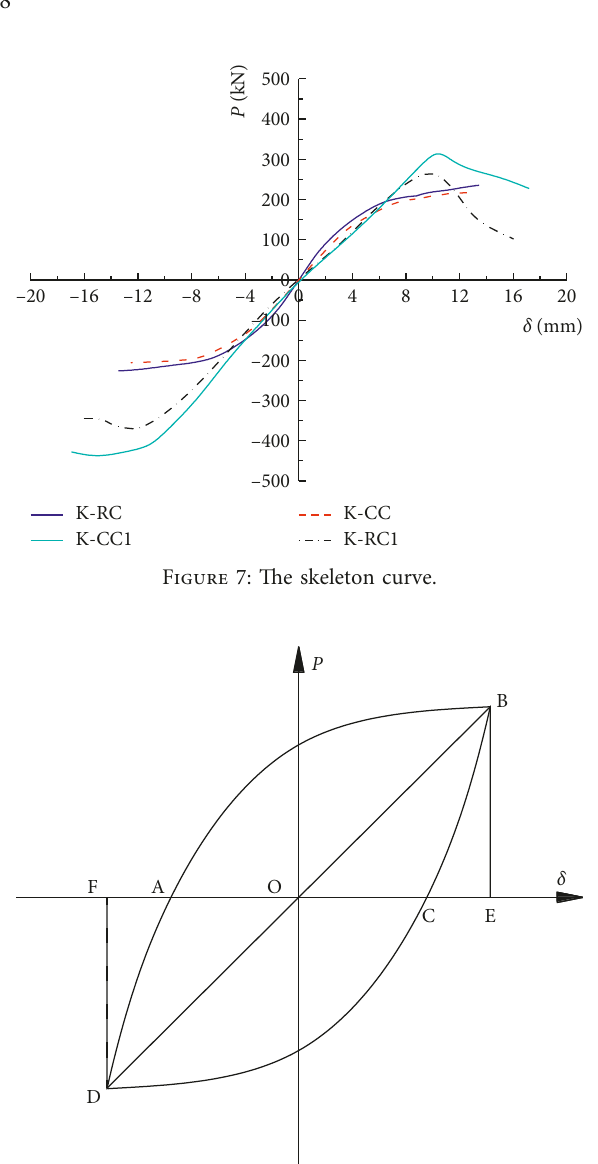
Figure 8: Typical hysteretic